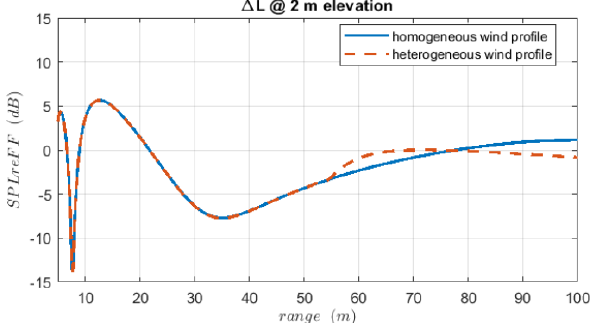
Figure 2: Portable mast with microphone array and associated weather station.